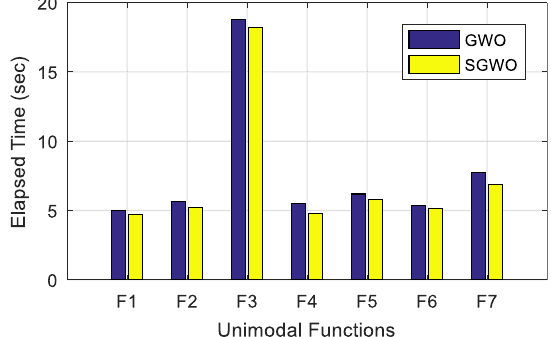
Fig. 6 Unimodal function ’ s Execution time